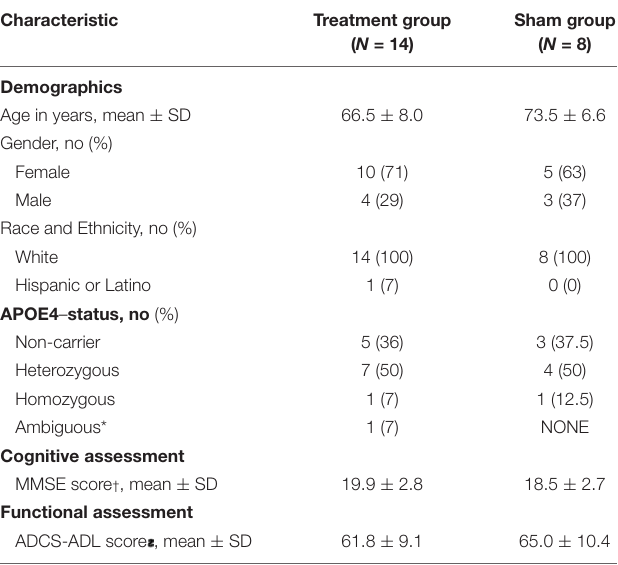
TABLE 1 | Demographic and clinical characteristics of patients at the initial assessment.